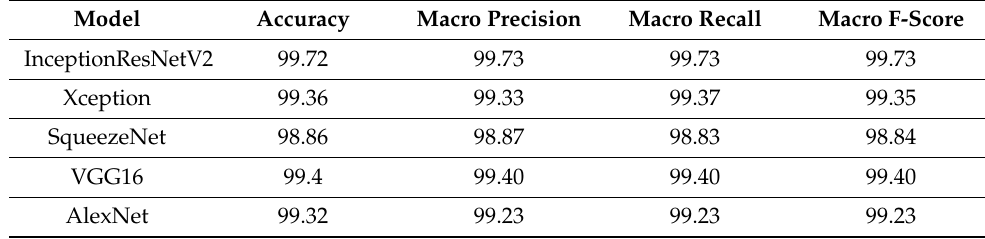
Figure 13. The number of real and generated images in the training and testing process. Table 6. Performance metrics of the detection